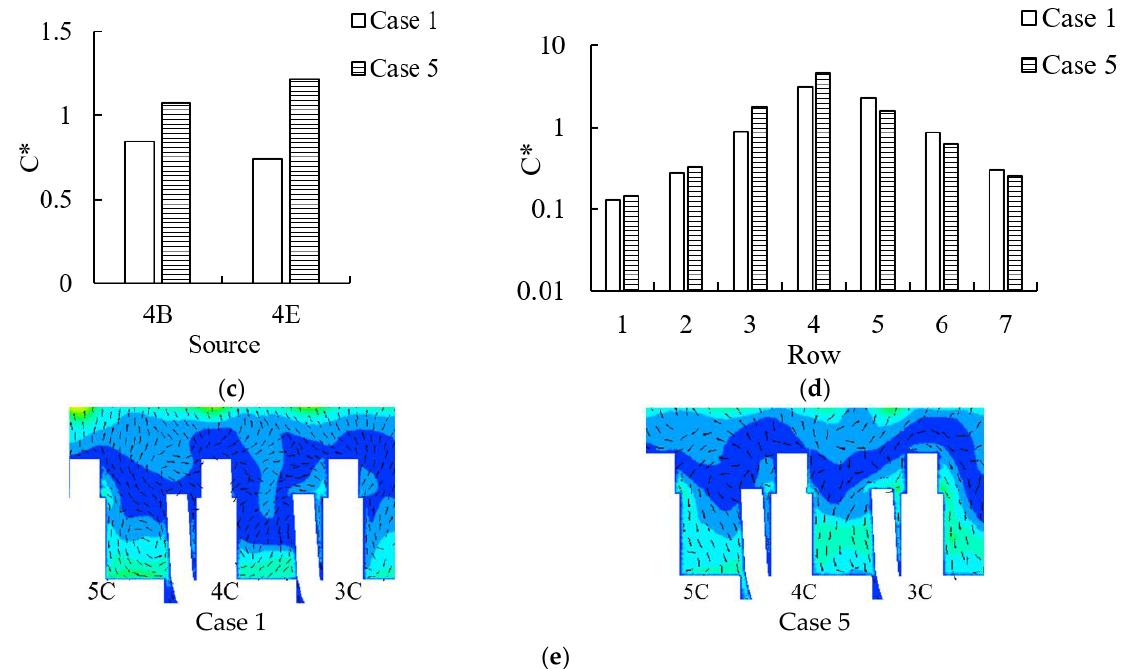
Figure 12. Airflow and normalized pollutant concentration distribution when misaligning the seat rows in Case 5: ( a ) air flow distribution in the cross-section across the heads of passengers in 4A to 4C, ( b ) airflow distribution in the cross-section across the heads of passengers in 4D to 4F, ( c ) comparison of the average pollutant concentration in respiratory zone of passengers in the half cabin opposite to the pollutant source between Cases 1 and 5, ( d ) comparison of the average pollutant concentrations in respiratory zone of the passengers in each row for the pollutant source at 4B, ( e ) airflow distribution in the longitudinal section from seats 3C to 5C in Cases 1 and 5.